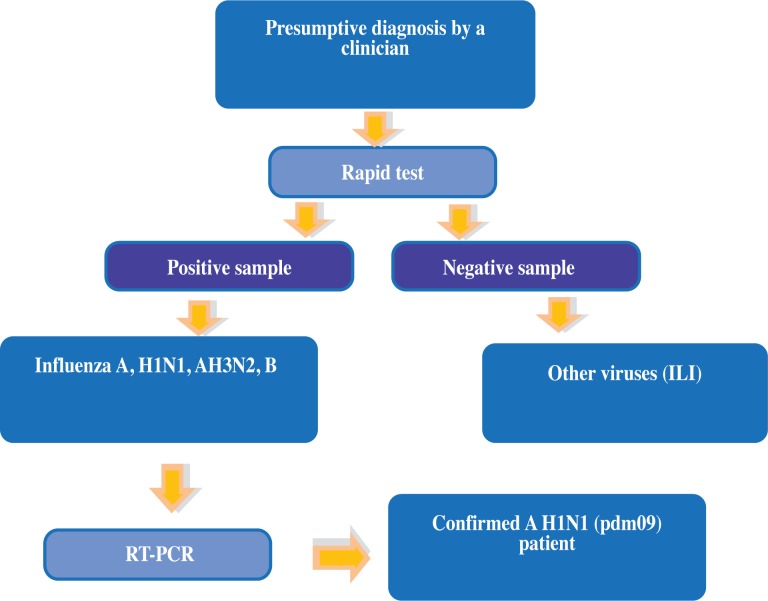
Flowchart for the collection and classification of patient samples in the study.The blood samples were collected from suspected influenza inpatients at INER from 2009–2012. Abbreviations: ILI: influenza-like illness; RT-PCR: real-time PCR.